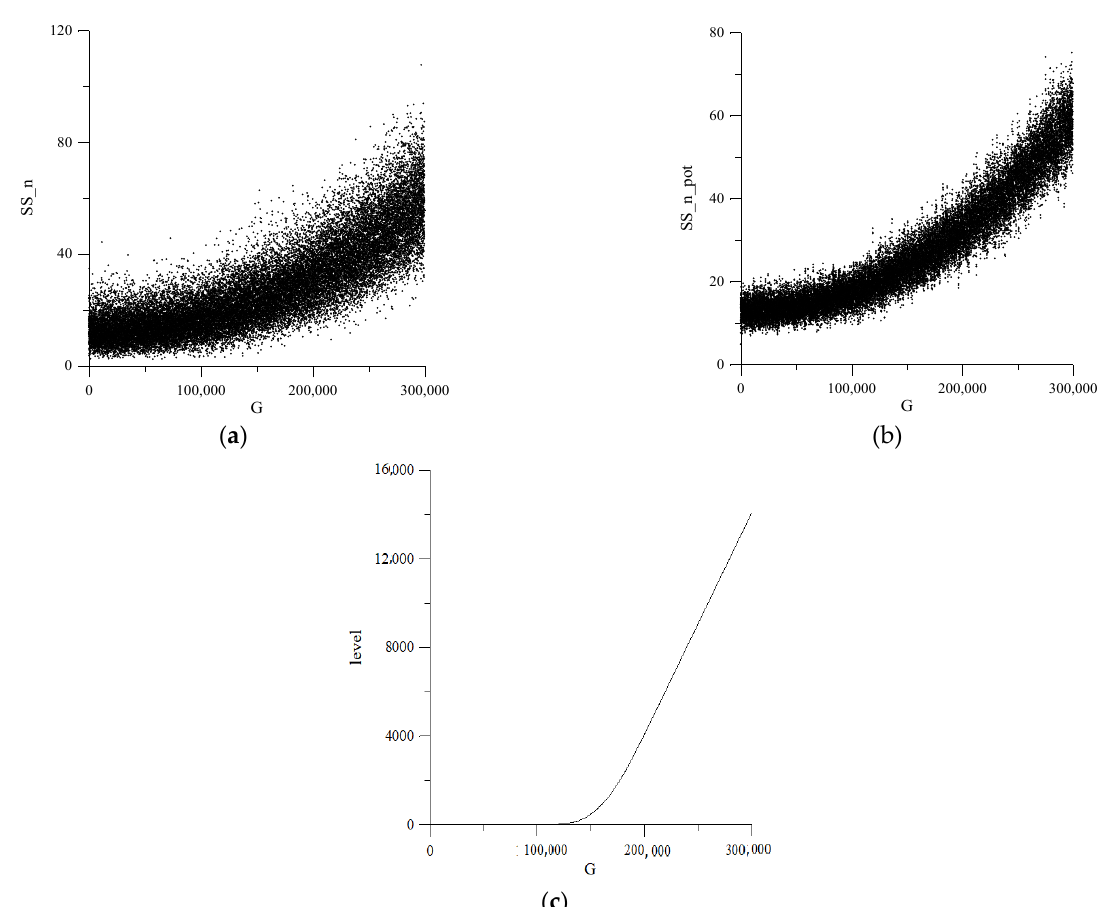
( ) 6 = q : ( a ) the value 2 χ ; ( b ) the average c χ χ − χ χ ; ( c ) number of values 2 greater than 2 . G— c с av с av cr